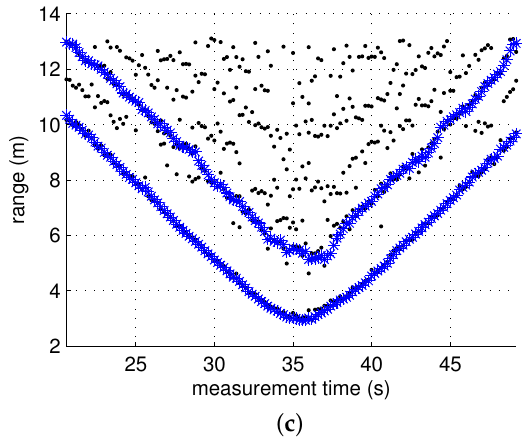
Figure 7. Scatter plots of clusters without ghost rejection for each scenario. ( a ) Scenario 1; ( b ) Scenario 2; and ( c ) Scenario